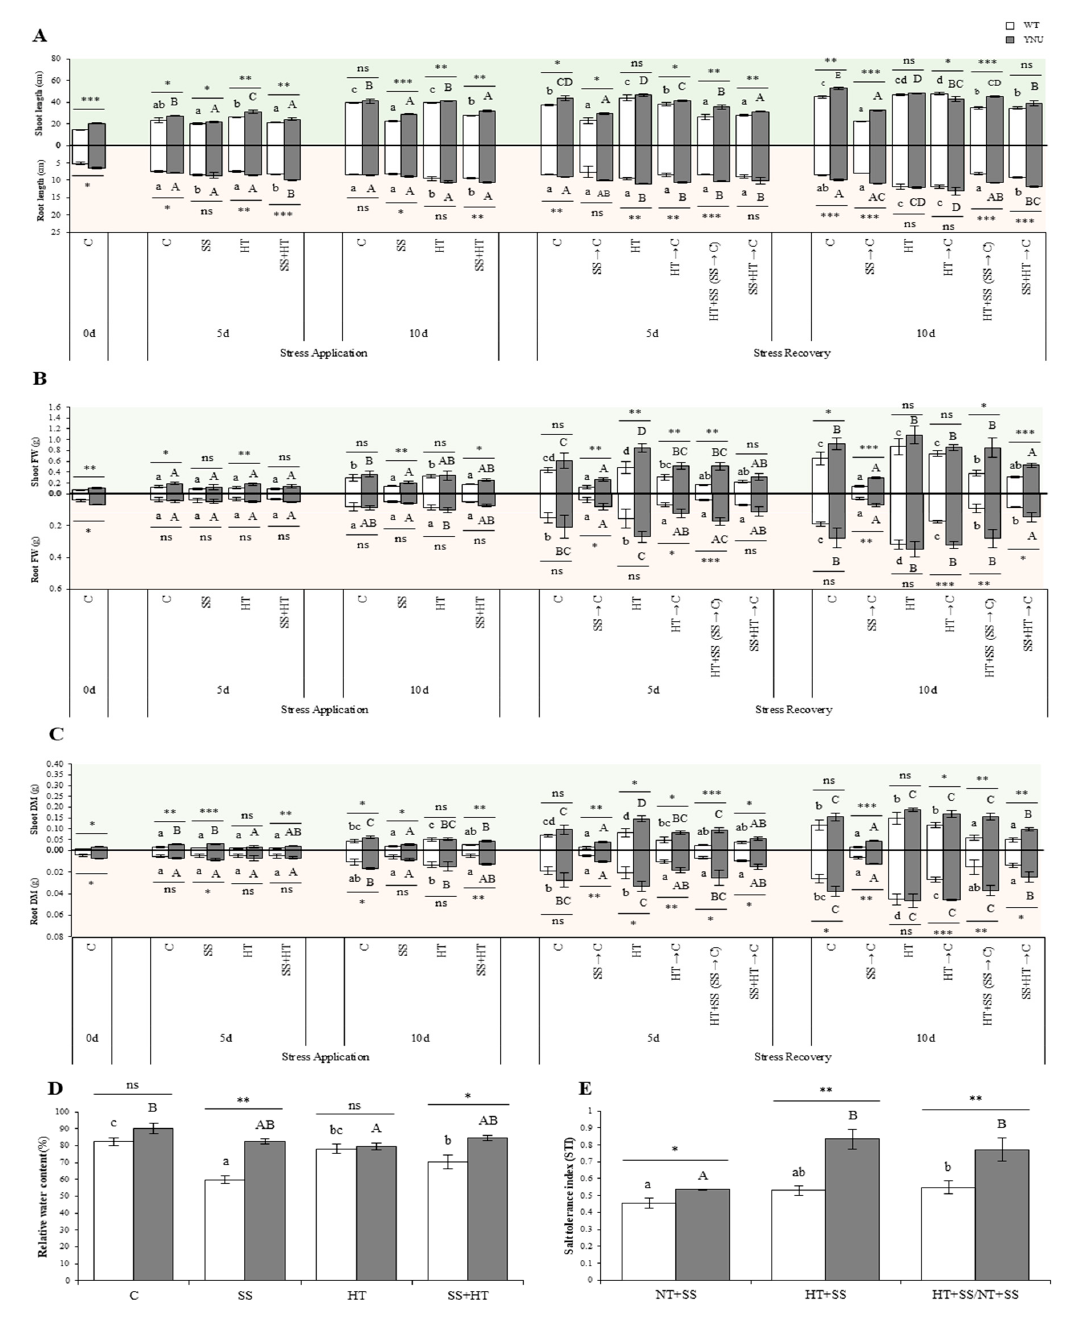
Figure 1. Morphological responses to salinity (SS), high-temperature (HT), and combined salinity and heat (SS + HT) of ‘Yukinkomai’ (WT) and ‘YNU31-2-4’ (YNU) rice seedlings; ( A ) Shoot (top panel) and root (lower panel) lengths, ( B ) shoot (top panel) and root (lower panel) fresh weight (FW), ( C ) shoot (top panel) and root (lower panel) dry matter (DM), ( D ) relative water content (RWT), and ( E ) salt tolerance index (STI) of WT and YNU plants under control normal-temperature (NT) (C: 26/23 °C, 0 mM NaCl), salt stress (SS: 26/23 °C, 75 mM NaCl), high-temperature (HT: 30/26 °C, 0 mM NaCl), combined stress (SS + HT: 30/26 °C, 75 mM NaCl), and stress-release (recovery) conditions. Bars = 10 cm. Values represent the means ± SE determined from three independent experiments using 4 plants in each experiment. Means within the same graph followed by different lowercase (WT) and uppercase (YNU) letters are significantly different at p < 0.05 according to the Tukey’s HSD test. Asterisks represent statistical significance of difference using Student’s t -statistic with *** p < 0.001, ** p < 0.01, * p < 0.05, ns: non-significant.